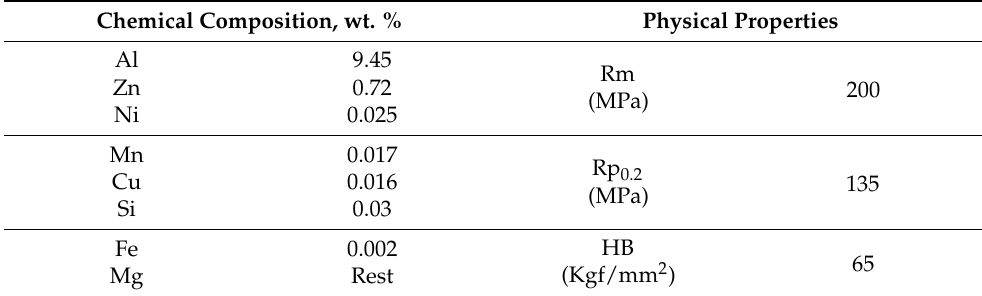
Table 2. Chemical composition and physical properties of AZ91HP magnesium alloy. Chemical Composition, wt.